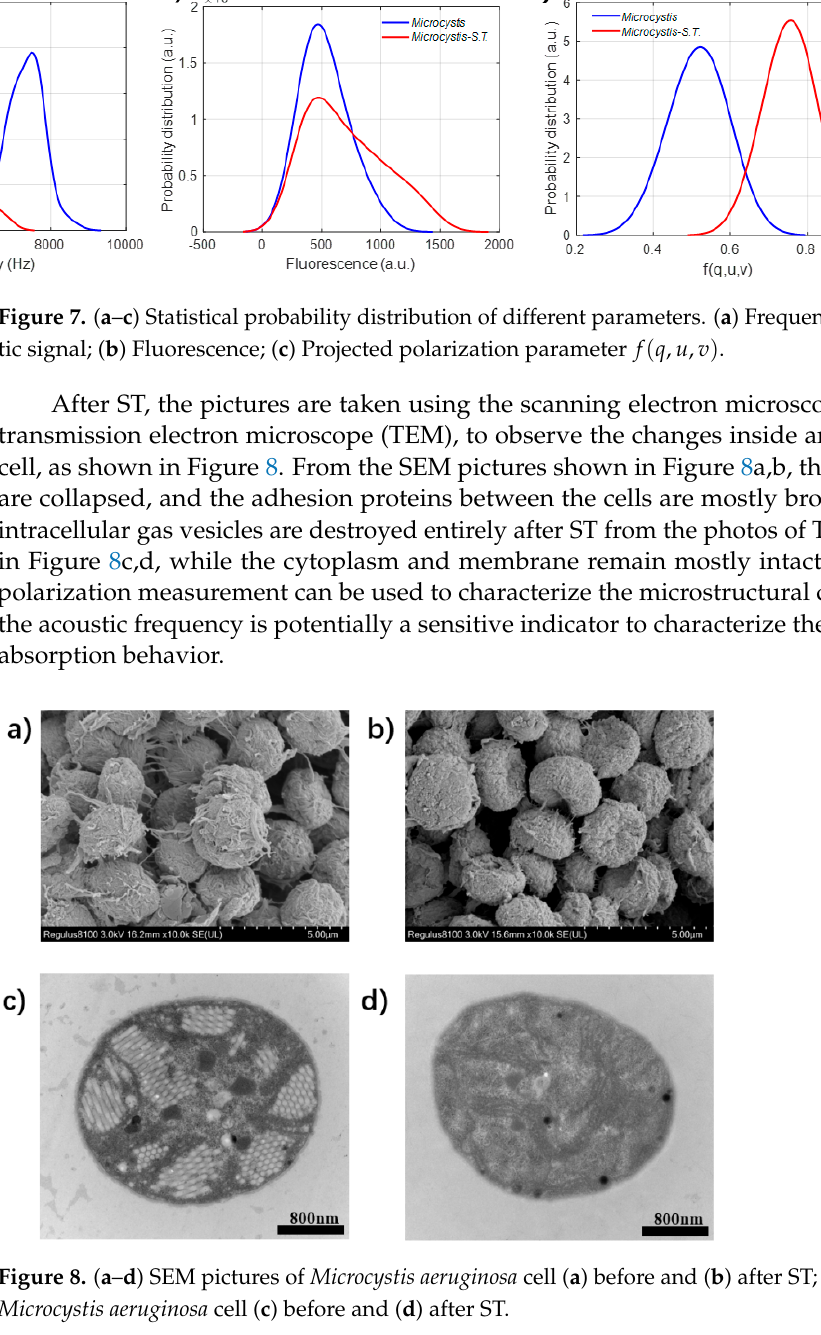
Figure 8 . ( a – d ) SEM pictures of Microcystis aeruginosa cell ( a ) before and ( b ) after ST; TEM pictures of Microcystis aeruginosa cell ( c ) before and ( d ) after ST. 4. Discussions The absorbed light is mainly consumed in the excitation of fluorescence and heat dis- sipation, and they are recorded as fluorescence and acoustic signal in our work, respec- tively, then these parameters can be evaluated in the energy aspect. For fluorescence, the original fluorescent voltage 𝐹(𝑡) is stored in the data acquisition card, the solid angle 𝛺 of the receiving light accounts for 0.0011 of the whole, and the sensitivity of photomulti- plier is 0.2 nW/V . Considering that the light beam is equally spitted into two beams with the splitter, the total energy of fluorescence 𝐸 (cid:3007) of an individual particle can be calculated by Equation (4), and the recording time is started from the initial time 𝑡 (cid:2868) to the end time 𝑡 (cid:2869) ,